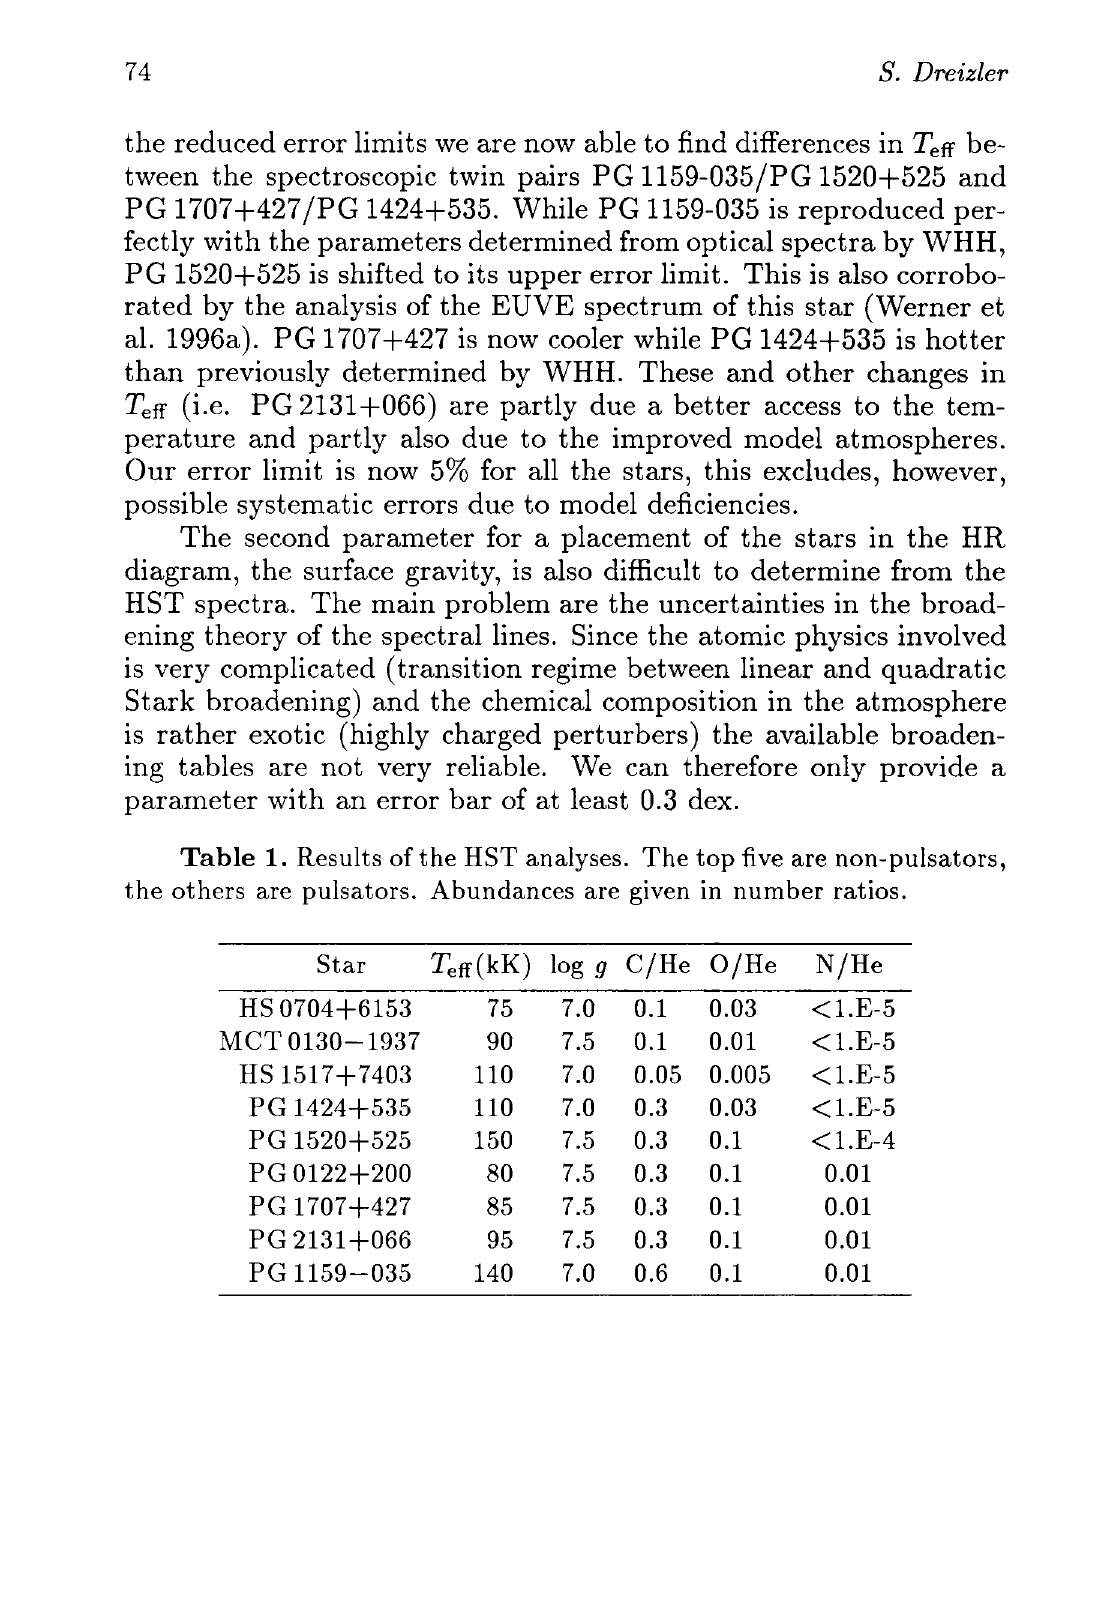
Table 1. Results of the HST analyses. The top five are non-pulsators, the others are pulsators. Abundances are given in number